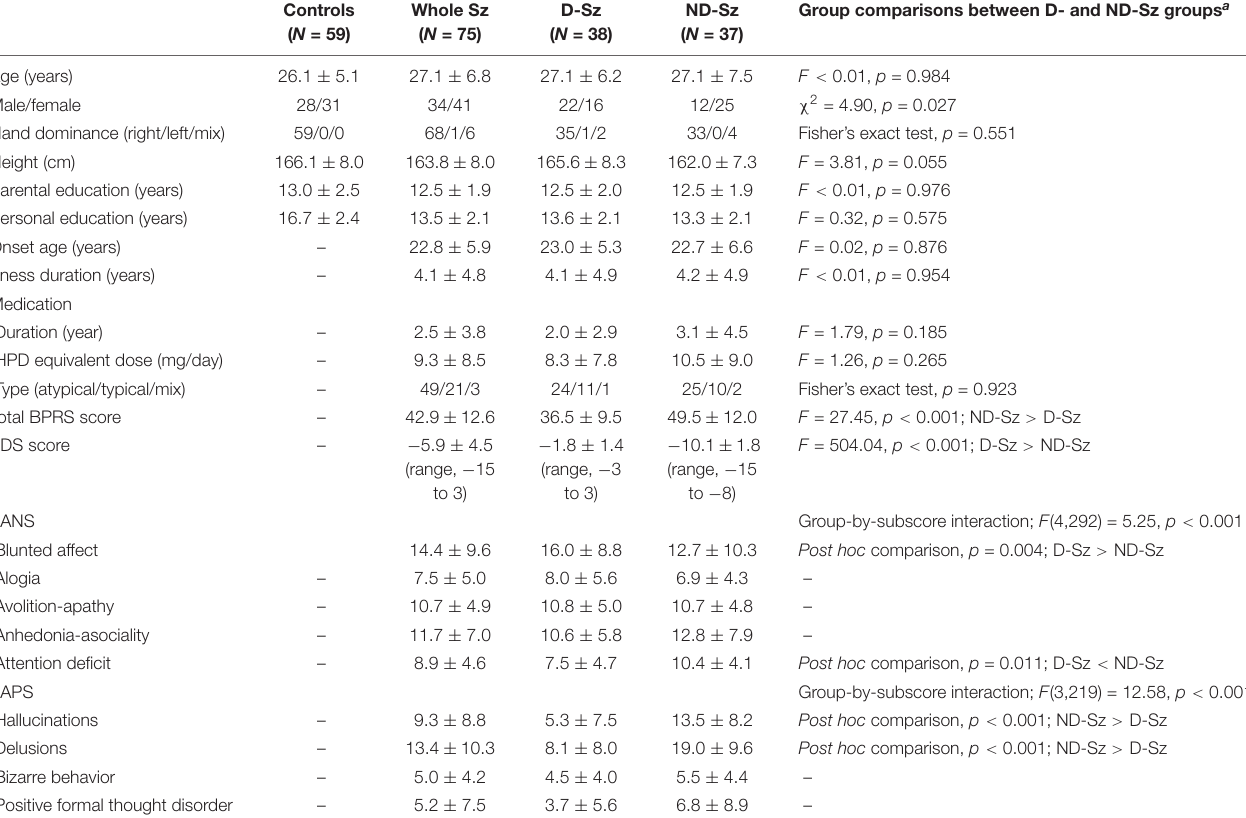
TABLE 1 | Sample characteristics of subjects in the present